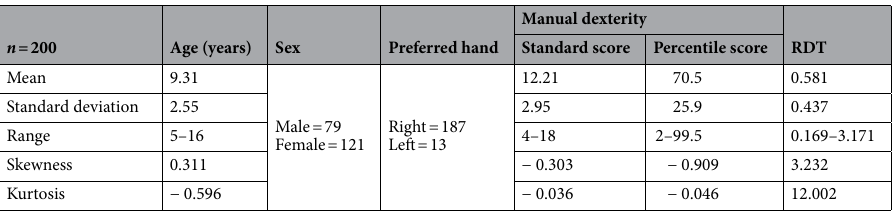
Table 1. Summary of data for all participating children. RDT action-outcome regularity detection